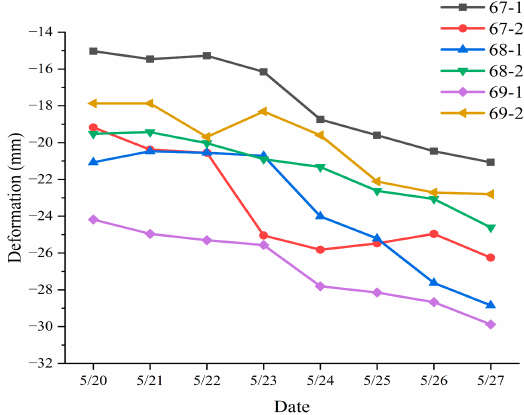
Figure 13. Surface settlement.